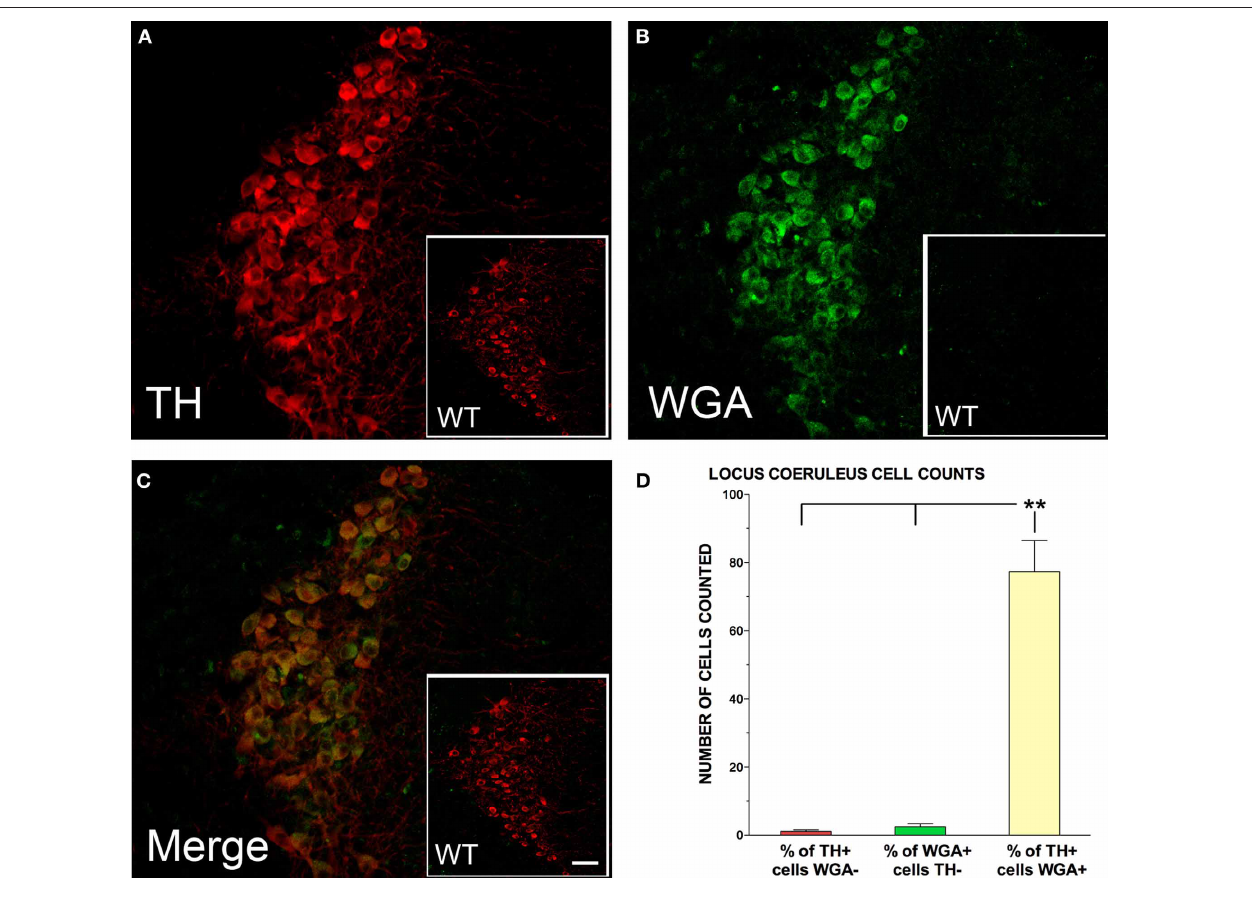
FIGURE 1 | Tyrosine hydroxylase (TH; red) and wheat germ agglutinin (WGA; green) immunolabelling of the locus coeruleus (LC) for representative DBH-WGA (A–C) and wildtype (WT; A–C inset) mice. (C) TH-positive neurons in the LC of DBH-WGA mice were also positive for WGA. LC neurons of wildtype mice were not immunoreactive for WGA